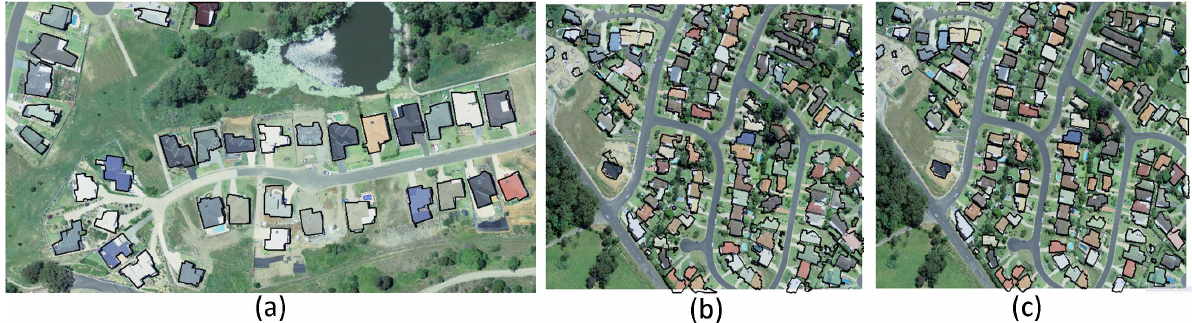
Figure 9: Map from the extracted buildings: (a) updated map for Scene 1, (b) automatic building detection for Scene 2 in December and (c) map from (b) using the